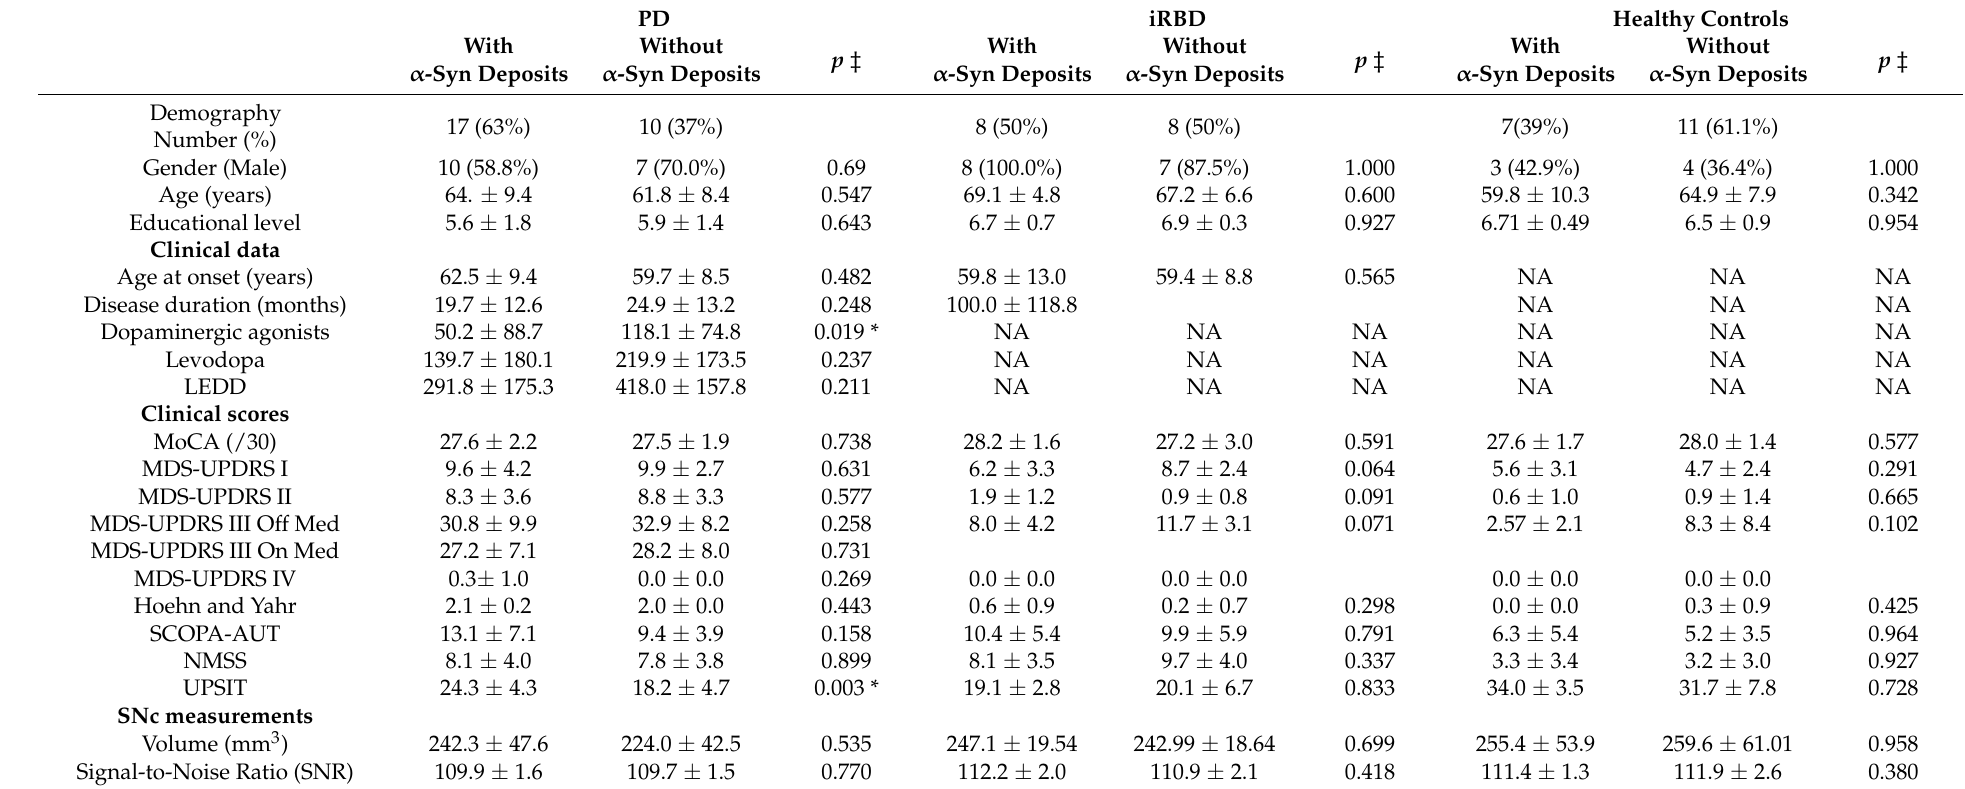
Table 2. Comparison between subjects with α -Syn deposits and subjects without α -Syn deposits in each clinical group. PD iRBD Healthy Controls With Without With Without With Without p ‡ p ‡ α -Syn Deposits α -Syn Deposits α -Syn Deposits α -Syn Deposits α -Syn Deposits α -Syn